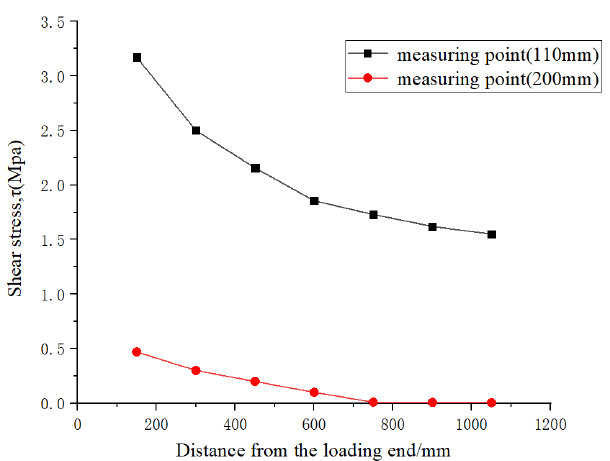
Figure 8. Shear stress distribution of the rock sample.